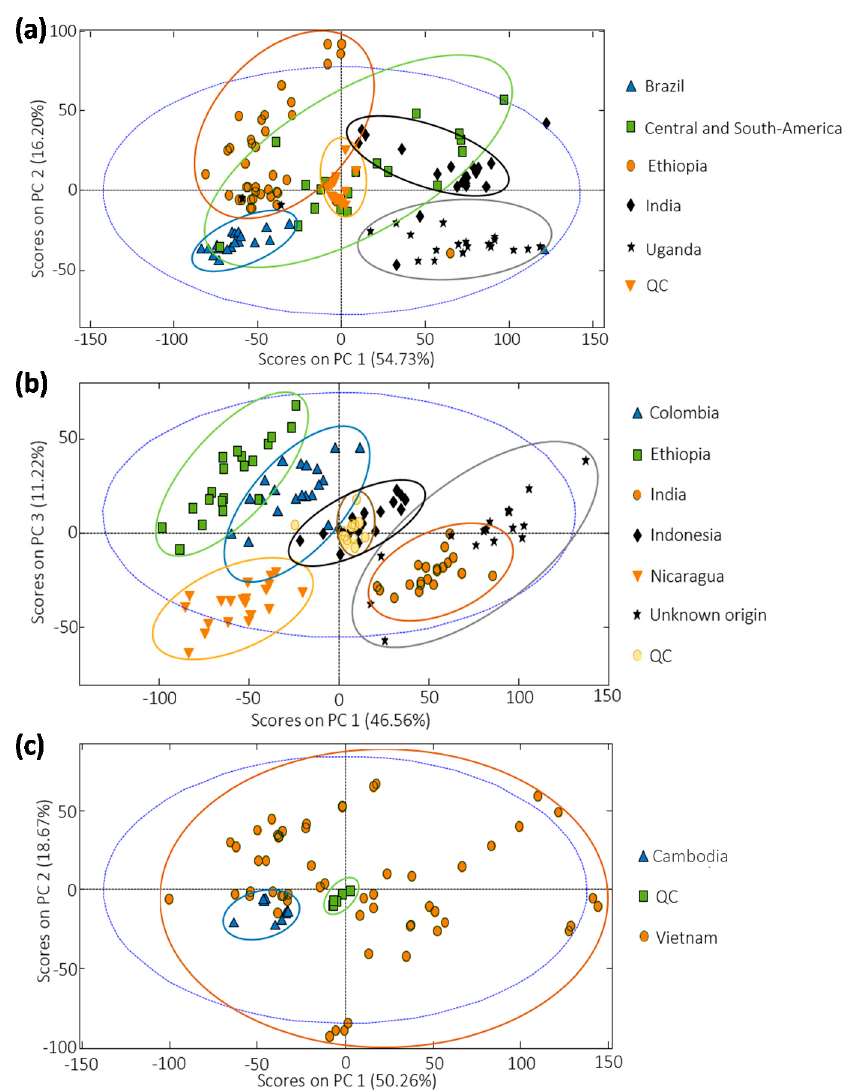
Figure 3. Scatter plot of scores for ( a ) Sample set 1 (PC1 vs. PC2), ( b ) Sample set 2 (PC1 vs. PC3), and ( c ) Sample set 3 (PC1 vs. PC2).